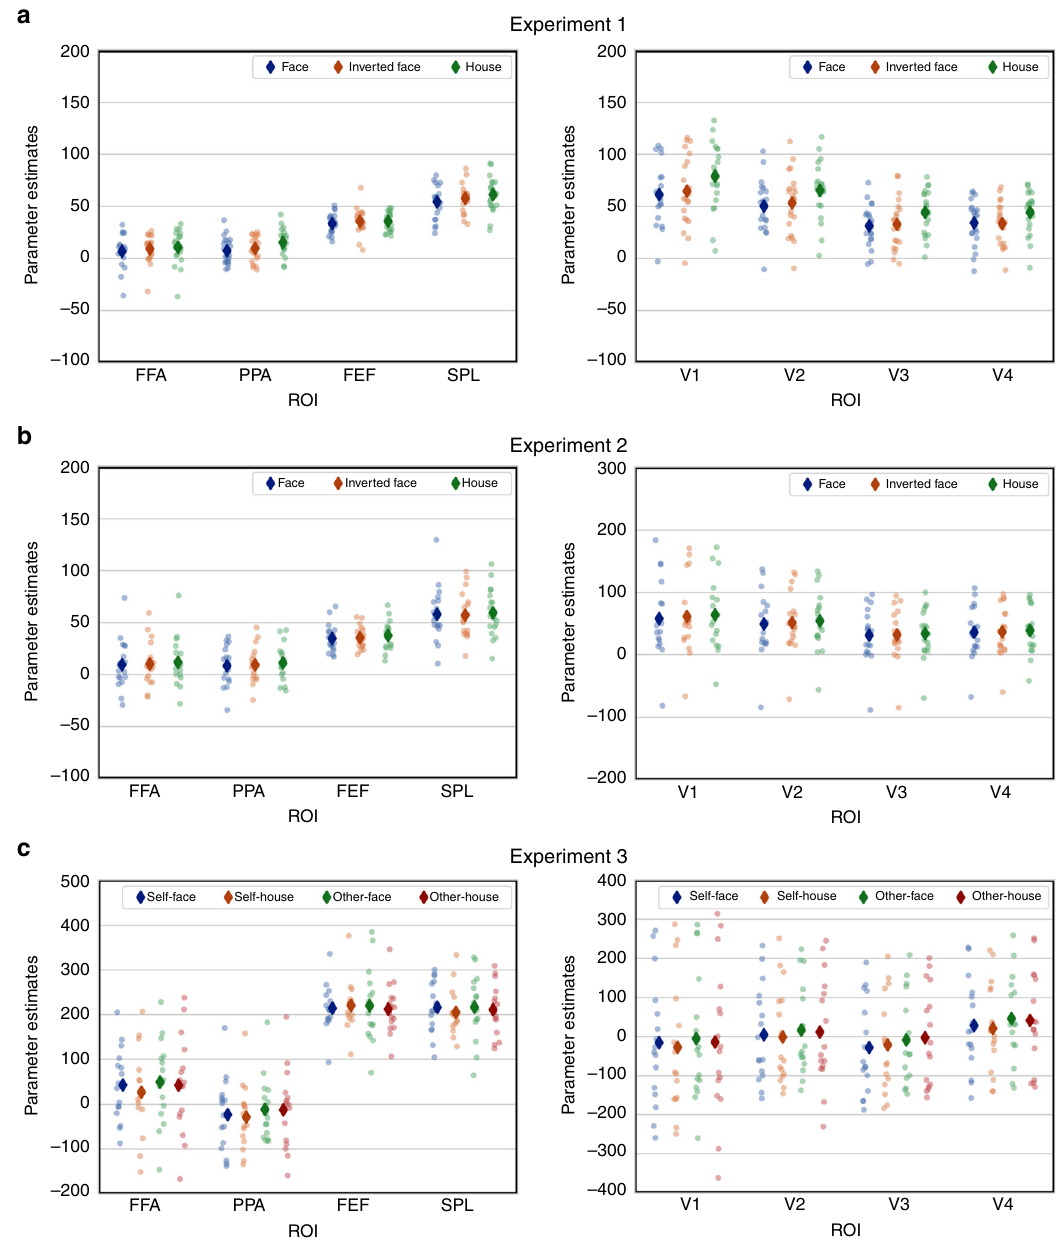
Fig. 3 Univariate analyses. Average standardized parameter estimates (diamond) and individual parameters (dots) extracted from the fusiform face area (FFA), parahippocampal place area (PPA), frontal eye fi elds (FEF), superior parietal lobule (SPL) and early visual areas for the Fixation Pattern conditions for Experiment 1 ( a ) Experiment 2 ( b ), and Experiment 3 ( c ). Individual data under different conditions are shown as color scales (Experiment 1 and 2: blue dots for face, orange dots for inverted face, green dots for house; Experiment 3: blue dots for self-face, orange dots for self-house, green dots for other-face, red dots for